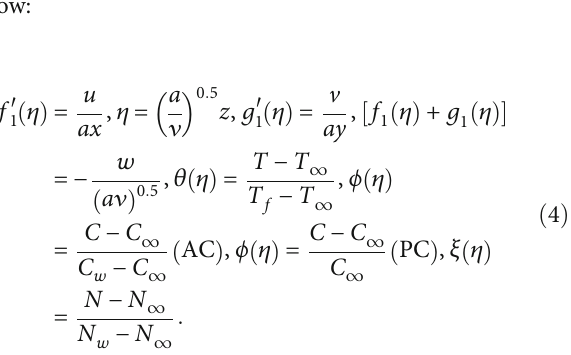
″ ð 0 Þ and − g ″ (0) for various values of ϵ 1 1 = λ = Nr = Rb = 0 1